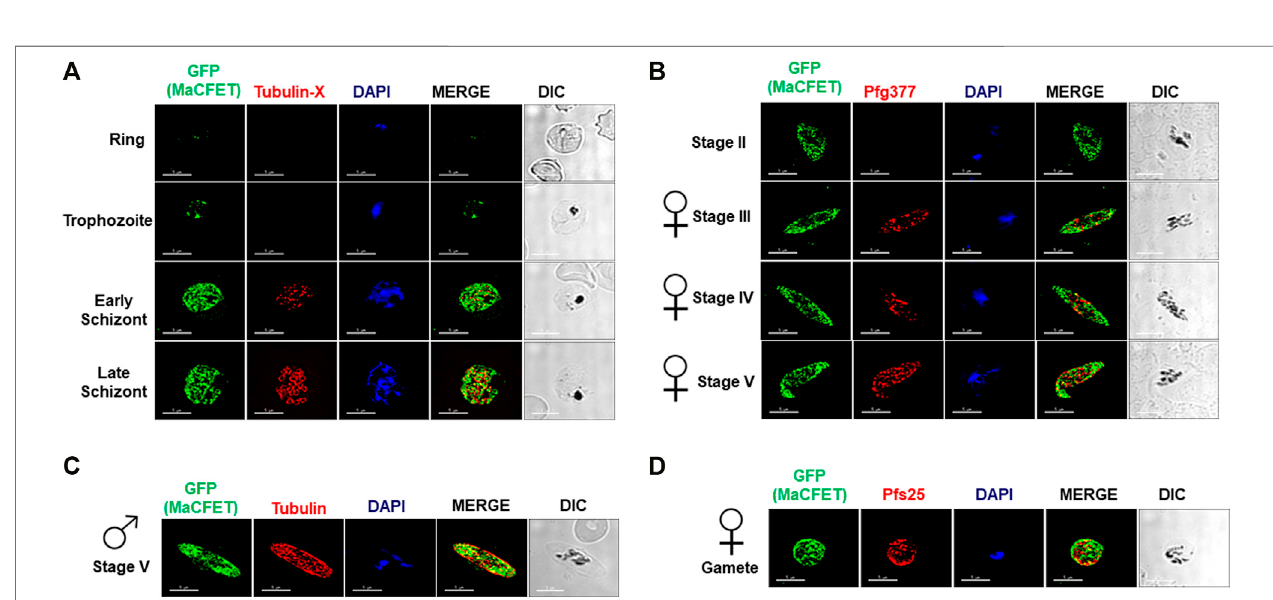
FIGURE 2 | Expression and localization of PfMaCFET in asexual and sexual stage parasites (A) IFAs were performed using thin culture smears of asexual stages (ring, trophozoite, early and late schizonts), (B) sexual (stage II-V gametocytes) stages, (C) male gametocyte, (D) female gamete using anti-GFP antibody (in green) in combination with anti-Tubulin X (A) , anti-PfG377 (B) , anti-Tubulin (C) anti-Pfs25 (D) . The parasite DNA was visualized with DAPI (blue). Representative images are shown. DIC, differential interference contrast. DAPI, 4 ′ ,6-diamidino-2-phenylindole, Scale bar = 5 μ m.